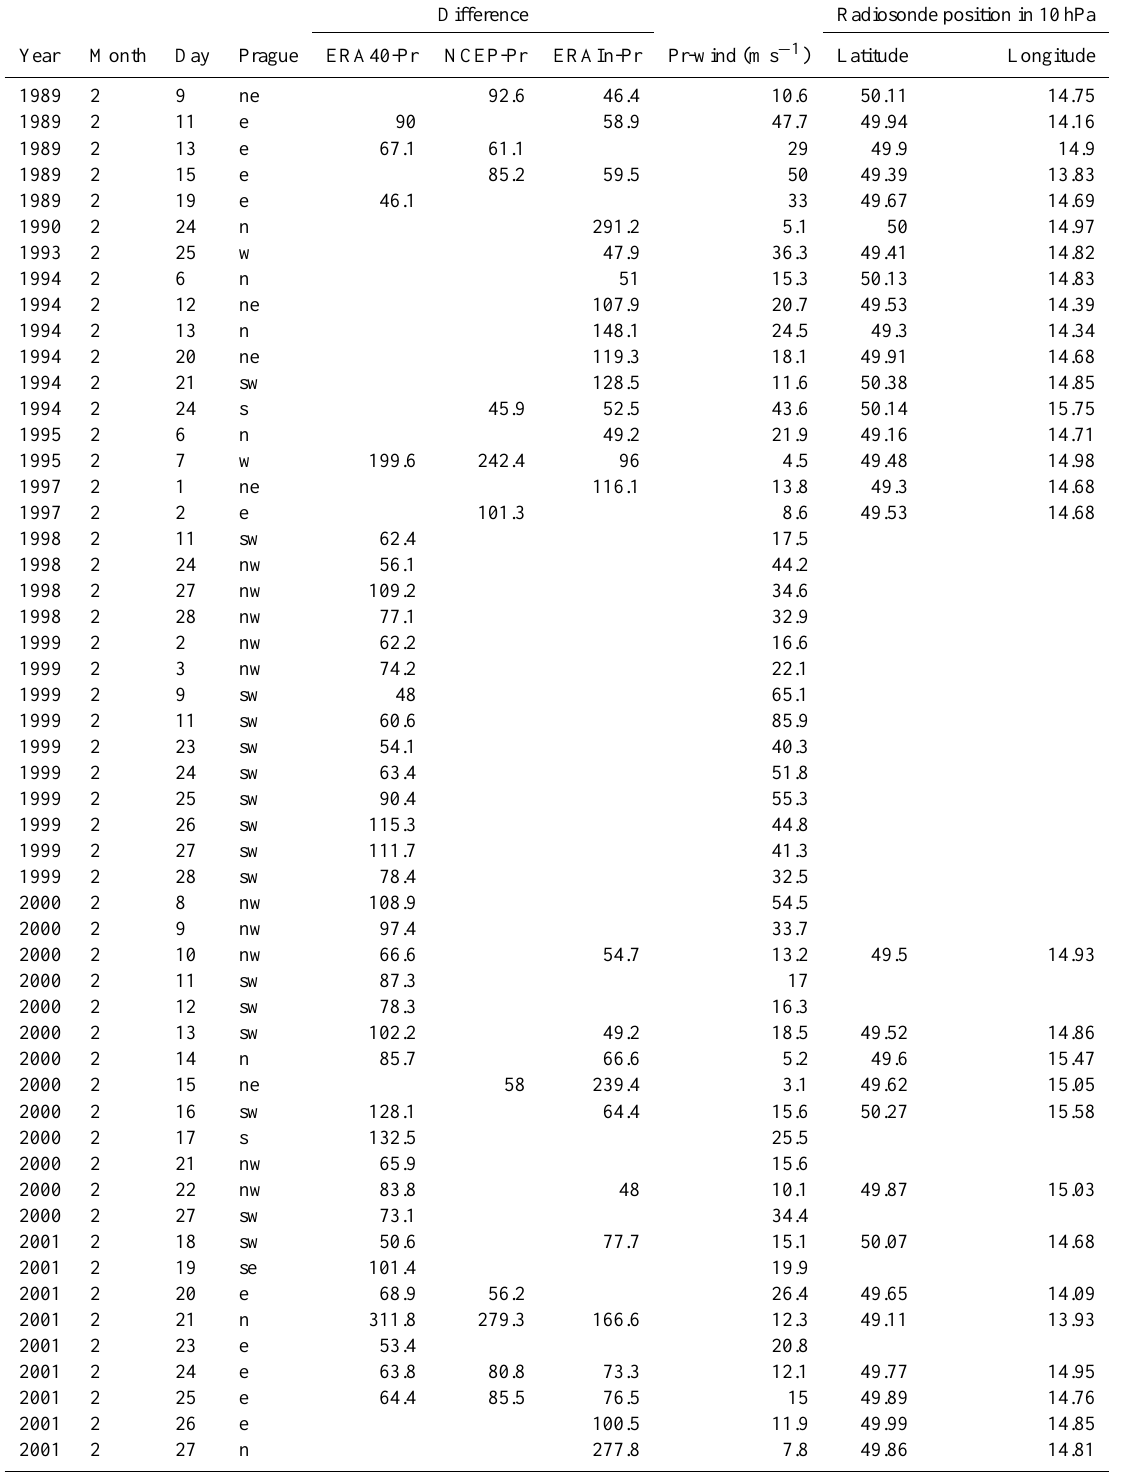
Table 1. All days with differences between reanalyses and Prague-Libus at 10hPa higher than 45 ◦ (W – westerlies), Prague-Libus wind speed, radiosonde position in 10hPa, February, 1989–2001, for grid point 50 ◦ N, 15 ◦ E.